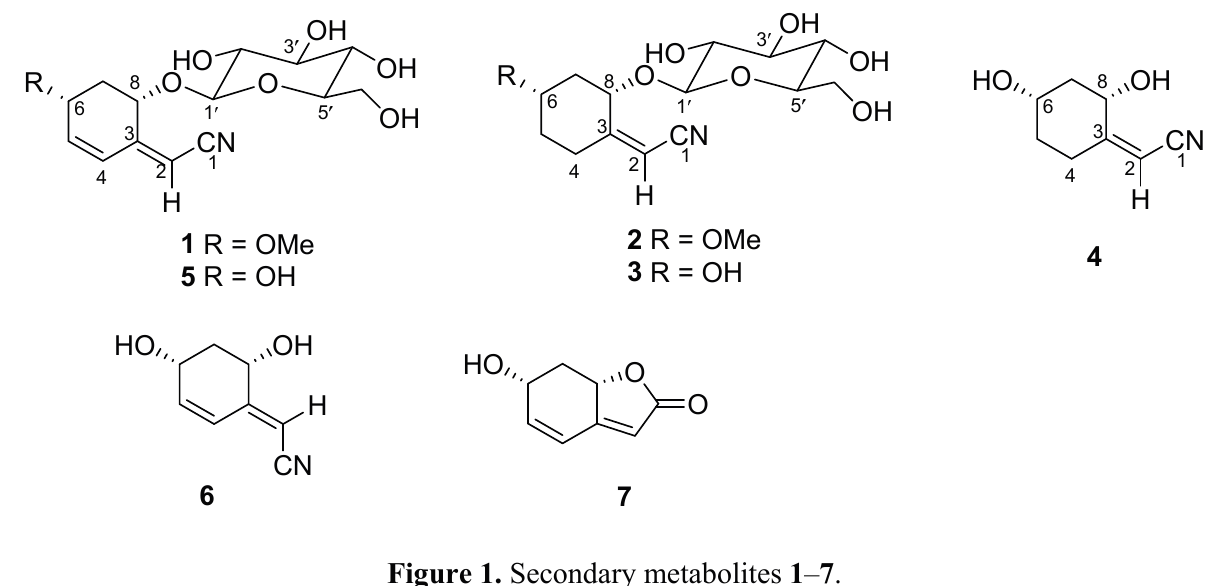
Figure 1. Secondary metabolites 1 – 7